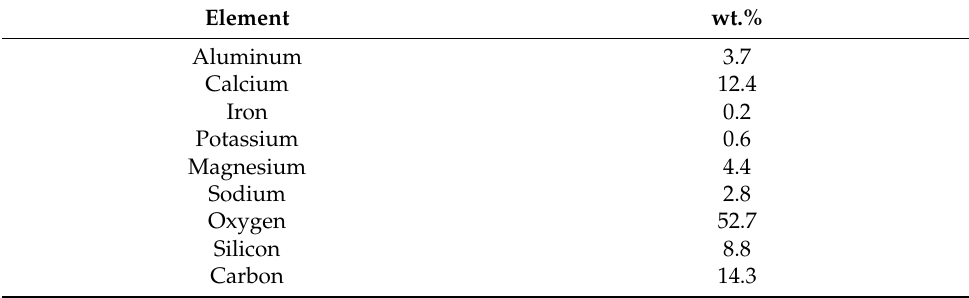
Table 6. Surface elemental composition of concrete dust from XPS.